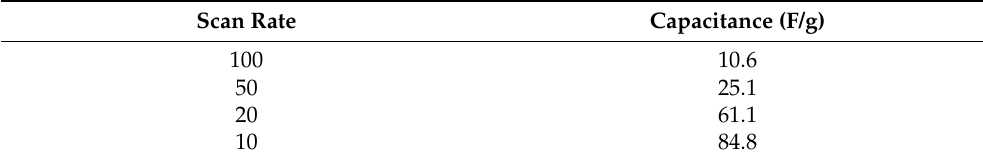
Figure 4. The CV profile for glycerolized the MC:DN:NH 4 SCN:Zn (II) metal complex electrolyte. Table 3. C s of the constructed EDLC utilizing glycerolized MC:DN:NH 4 SCN:Zn (II) metal complex electrolyte.